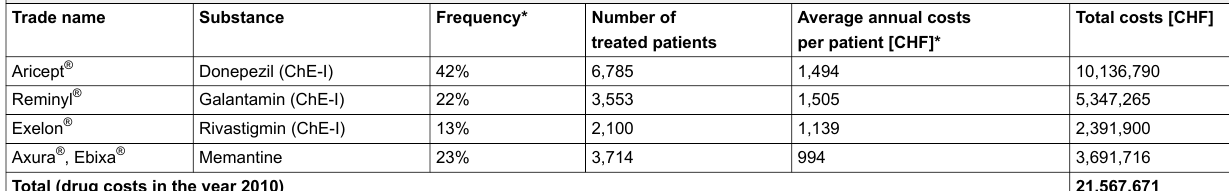
Table 4: Total drug costs in 2010 based on the estimates from Helsana. Trade name